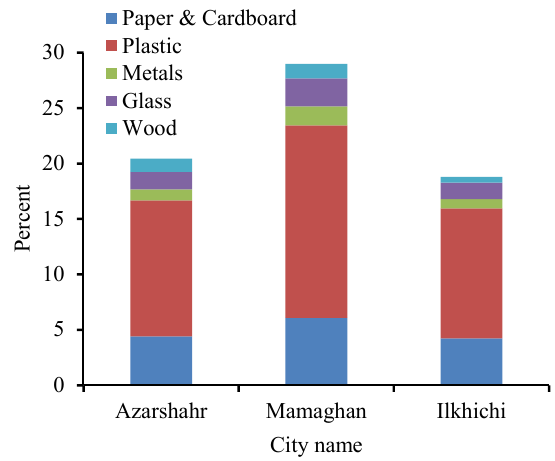
Fig. 3. Annual average of recyclable wastes in the studied